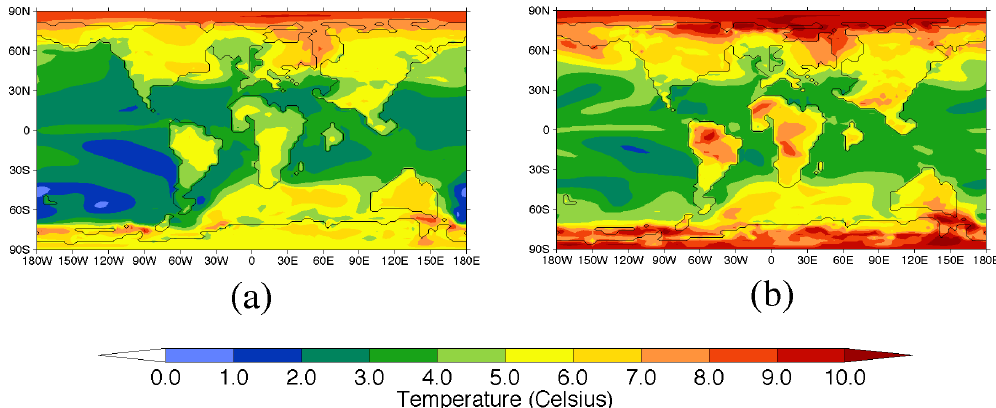
Fig. 9. Annual surface air temperature difference between (a) 4 × SHRUB and 2 × SHRUB and (b) 4 × DYN and 2 × DYN. Only differences at the 95% confidence level are shown.